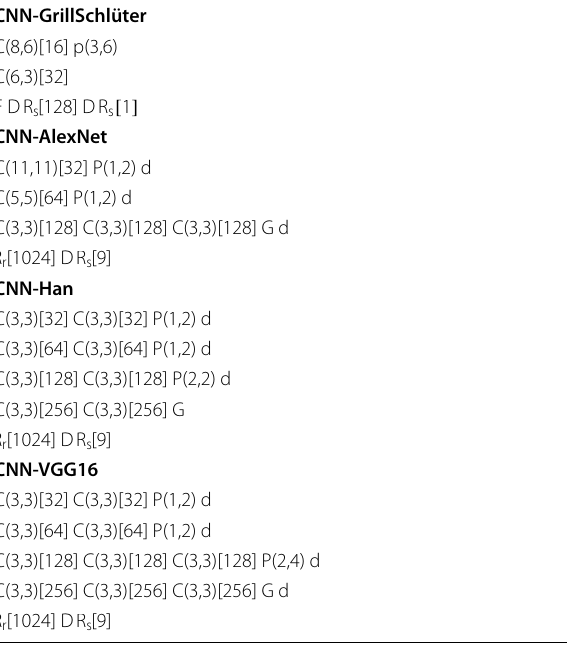
Table 5 Evaluation measures for music segmentation with respect to different boundaries. F-measure ( F ), precision ( P ), and recall ( R ) are estimated for all boundaries (A) and boundaries coming with instrument (I), key (K), or tempo (T) change. Abbreviations for the feature groups: MelS : the Mel spectrum; SemS : the semitone spectrum; Fluct : fluctuation patterns. Best values are marked with bold font